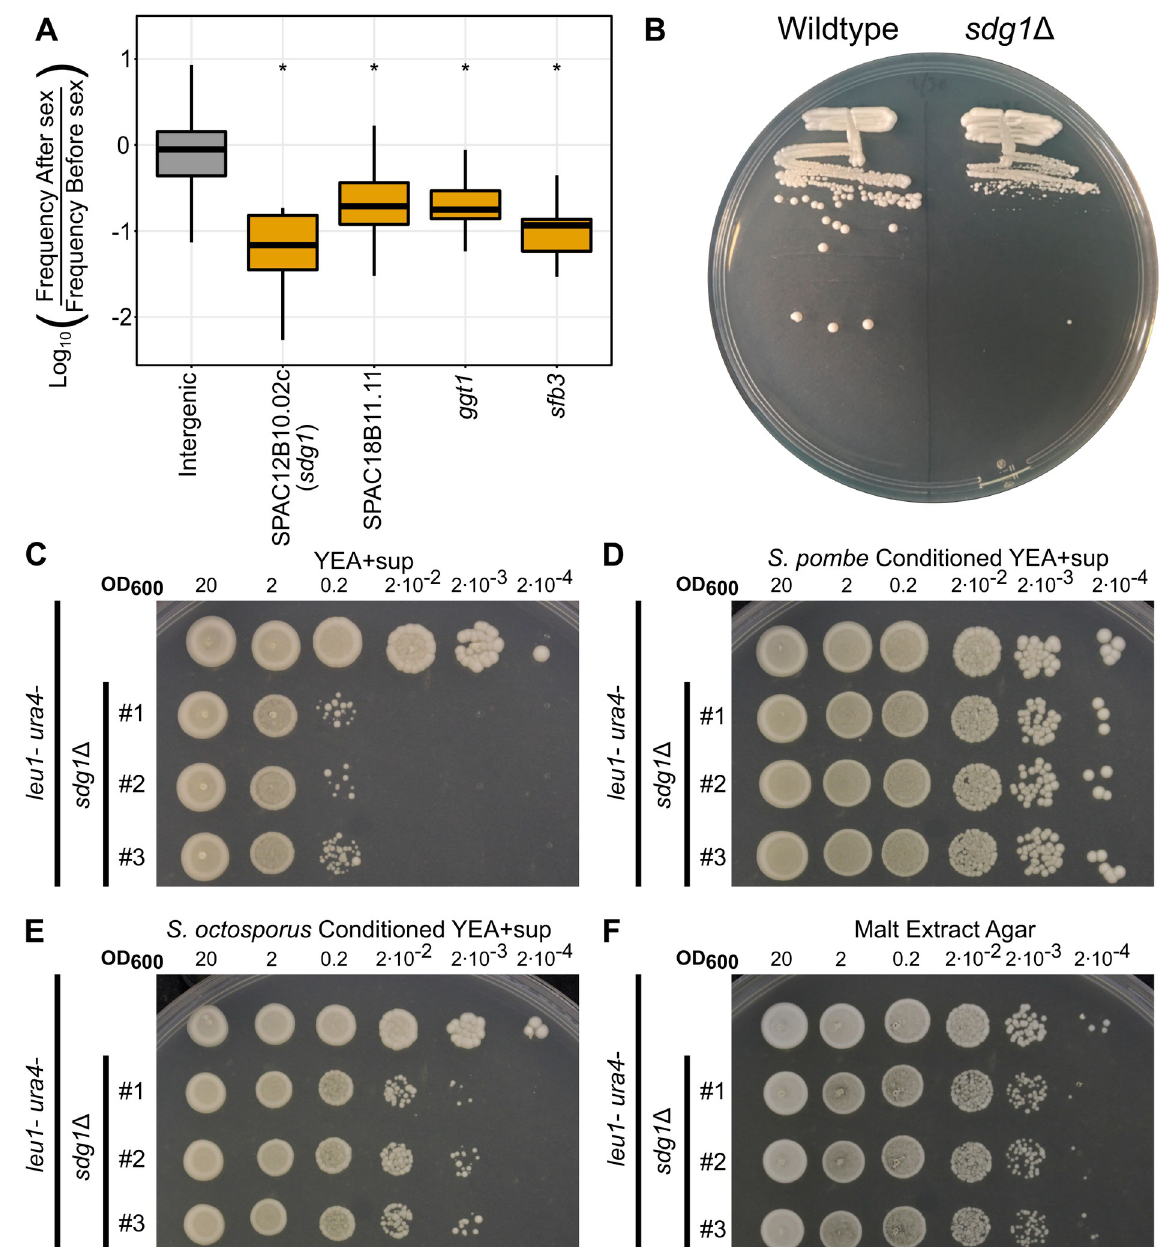
Fig 5. sdg1 Δ mutants have a density-dependent growth defect that can be rescued by conditioned medium. A) Boxplot displaying distribution of log 10 -adjusted fold changes in insert density after sex (ie. frequency after sex/frequency before sex). Boxplots show first quartile, median, third quartile. The whiskers show the range to a maximum of 1.5 times the interquartile range above and below the first and third quartile, respectively. Outlier data points (outside the whiskers) are not displayed. This results in 5,716 of 235,578 intergenic sites, 0 of 24 from SPAC12B10.02c/ sdg1 , 3 of 148 from SPAC18B11.11, 2 of 22 from ggt1 , and 1 of 14 from sfb3 not being displayed although those data were considered in the statistical analyses. Inserts in noncoding regions are indicated in grey and inserts into candidate genes are shown in orange. B) Streaking assay showing a parent S . pombe strain ( ura4 -D18, leu1 -32) and an sdg1 Δ mutant ( sdg1 Δ ::kanMX4, ura4 -D18, leu1 -32) struck to single colonies on a YEA+SUP plate after 4 days at 32˚C. C-F) Spot dilution assays with 5 μ L spots plated. The initial leftmost spot is of OD 600 = 20 culture and each successive spot is a 10-fold dilution, so that the final spot should be 10 5 less concentrated than the first. All four experiments were conducted on the same day with the same dilution series of parent strain ( ura4 -D18, leu1 -32) and three independent sdg1 Δ mutants on the same genetic background ( sdg1 Δ ::kanMX4, ura4 -D18, leu1 -32). C) Spotted to standard yeast extract agar with supplements (YEA+SUP) and incubated for 4 days at 32˚C. D) Spotted to conditioned yeast extract agar + supplements (see methods) made from parent strain S . pombe ( ura4 -D18, leu1 -32) and incubated for 4 days at 32˚C. E) Spotted to conditioned yeast extract agar made from wild type S . octosporus and incubated for 4 days at 32˚C. F) Spotted to malt extract agar and incubated at 25˚C for 4 days.